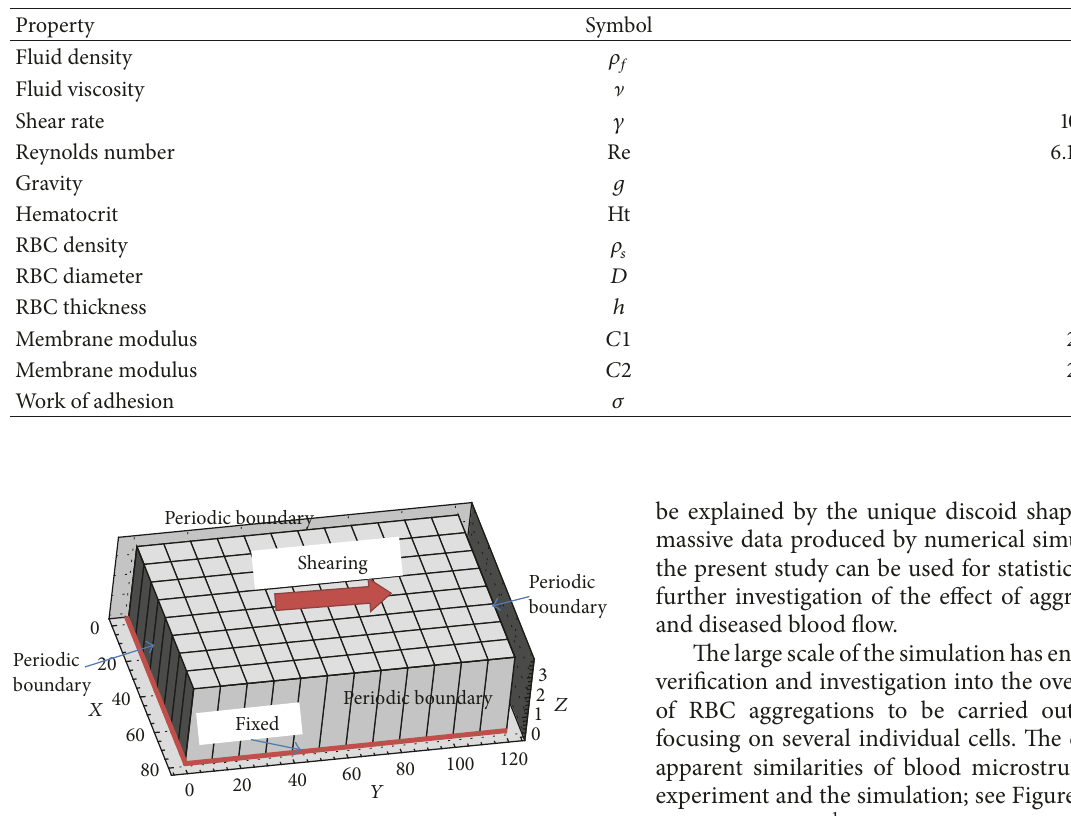
bottom plate. The Reynolds number was calculated based on the shearing velocity Us and the flow thickness ℎ . The total number of RBCs was 49,512, which yielded a hematocrit of around